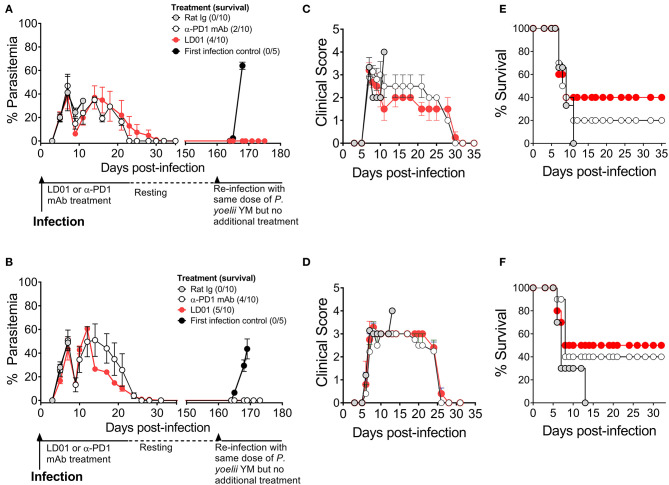
LD01 improves survival and promotes a long-lived protection memory response from lethal malaria. (A–D) 104 Py YM-infected red blood cells were injected IV into mice (n = 10), treated IP with LD01 or antibody, and monitored daily for (A,B) parasitemia, (C,D) clinical scores and (E,F) survival. The dose of LD01 delivered was 100 or 200 μg/injection/mouse administered twice daily on either days 1, 2, 3, 4, and 5 (A) or days 3, 4, 5, 6, and 7 (B). 200 μg doses were given on days 1 and 2 (A) or days 3 and 4 (B) with 100 μg doses administered on days 3, 4, and 5 (A) or days 5, 6, and 7 (B) respectively. The dose of anti-PD1 mAb and control rat IgG delivered was 200 μg/injection/mouse administered daily on either days 1, 3, and 5 (A) or days 3, 5, and 7 (B). (A,B) Parasitemia was assessed beginning at day 3 and blood films were made every 1–2 days up to day 35. Surviving mice were then rested. On day 160, along with a new group of first infection control mice (n = 5), they were infected with 104 Py YM-infected red blood cells (A,B). The mice were monitored daily for survival and parasitemia. The two surviving mice treated with α-PD1 mAb in (A) were not re-challenged. Data are expressed as the mean ± SEM percent of malaria-positive RBC of total RBC (A) or ± SEM of clinical scores (B).